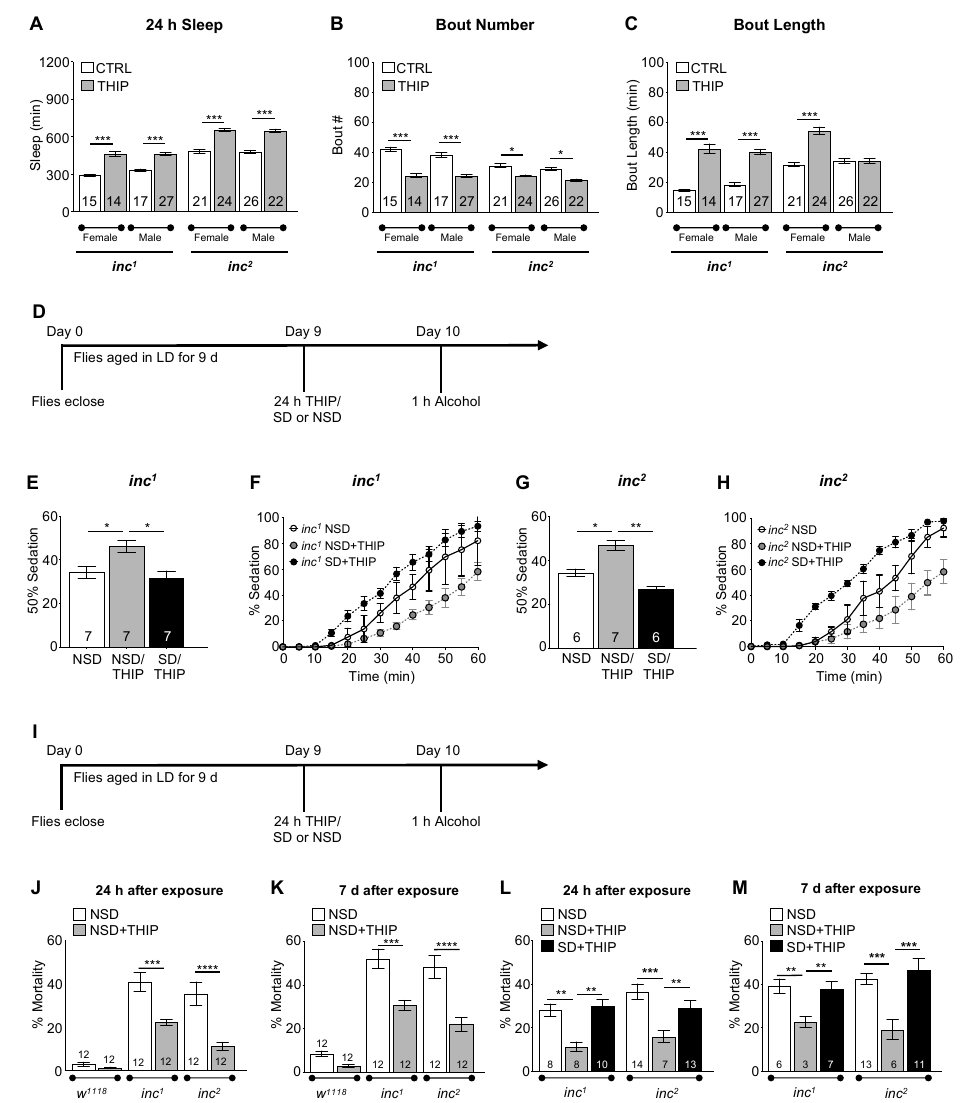
Figure 6. Pharmacologically increasing sleep in insomniac mutants significantly increases behavioral resistance to alcohol sedation and ameliorates alcohol-induced mortality. ( A – C ) Comparison of sleep profiles between w 1118 and THIP-fed inc 1 and inc 2 flies housed in LD cycles. Compared to control inc 1 and inc 2 flies, THIP-fed flies demonstrated significantly increased and consolidated sleep (( A ), ANOVA: F 7,158 = 94.36, p < 0.001; * specifies significant differences between groups as indicated by Bonferroni post hoc analyses) with a decreased number of sleep bouts (( B ), ANOVA: F 7,158 = 45.10, p < 0.001), as well as increased bout duration for most groups (( C ), ANOVA: F 7,158 = 42.62, p < 0.0001). ( D – H ) To determine whether THIP treatment and increased sleep buffered alcohol sensitivity, inc 1 and inc 2 flies were aged in LD cycles for 9 d and transferred to media containing 0.1 mg/mL THIP or received THIP treatment while being sleep-deprived for 24 h. On day 10, inc 1 and inc 2 flies were exposed to 50% alcohol vapor for 1 h at ZT 9 with sedation assessed every 5 min during alcohol exposure ( D ). Pharmacologically increasing sleep (NSD/THIP) in inc 1 and inc 2 flies significantly increased the resistance to alcohol-induced sedation compared to non-sleep-deprived (NSD) inc 1 and inc 2 flies (( E ), ANOVA: F 3,18 = 12.22, p < 0.001; and ( G ), ANOVA: F 3,16 = 44.38, p < 0.001, respectively; * specifies significant differences between groups). THIP treatment had no effect on alcohol sensitivity in sleep-deprived (SLD) inc 1 and inc 2 flies, indicating that the alcohol resistance observed in NSD THIP-treated flies was not due to buildup of GABA-A receptor tolerance. ( F , H ) The complete alcohol sedation time course. ( I – K ) To determine whether increased sleep buffered against the toxic effects of alcohol, inc 1 , inc 2 , and w 1118 flies were aged in LD cycles for 9 d and transferred to media containing 0.1 mg/mL THIP. On day 10,